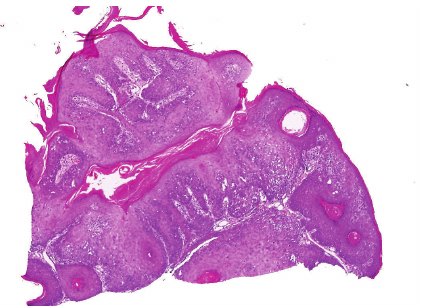
Figure 3: Bowen disease: Shave biopsy specimen showing mainly papillomatous epidermal lesion with hyperkeratotic horn. Inset: closer view of the underlying lesional epidermis shows cells with nuclear pleomorphism, prominent nucleoli, and frequent and abnormal mitotic figures. (H&E, × 20; Inset: × 400).